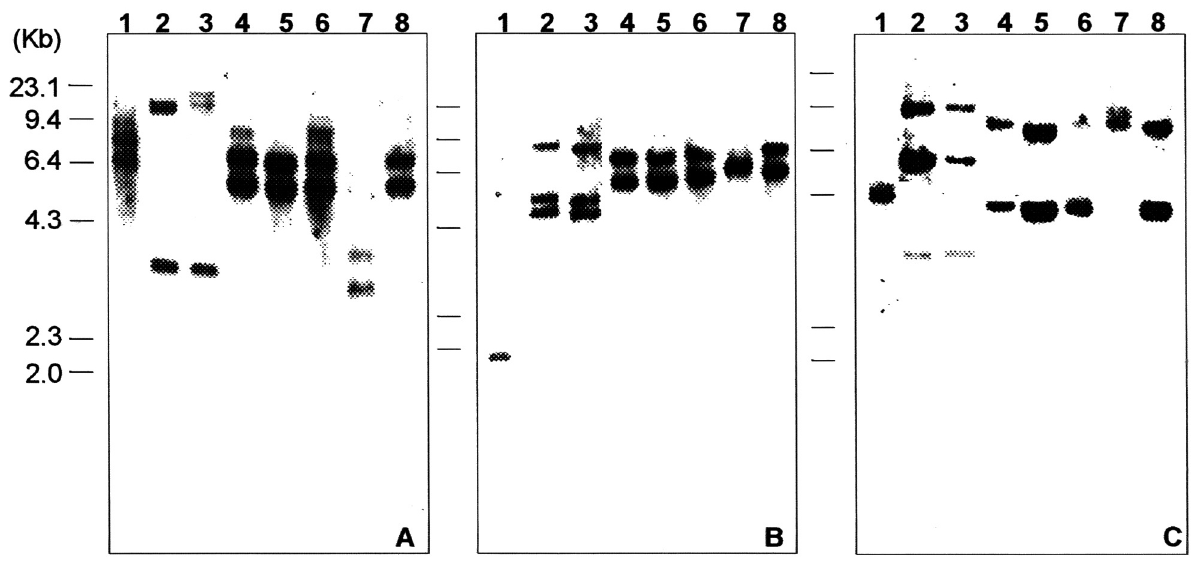
Figure2 -SouthernblotanalysisoftotalDNAfromdifferent Penicillium species.Therestrictionenzymes Eco RI(A), Sac I(B),and Sal I(C)wereusedto digesttotalDNAfrom P.chrysogenum (1), P.charlesii (2), P.citrinum (3), P.expansum (4), P.griseoroseum (5), P.italicum (6), P.janthinellum (7),and P. purpurogenum (8). Membranes were hybridized at 60 °C with the 420-bp fragment corresponding to a conserved domain of endoPG genes from P. griseoroseum . Phage λ DNA digested with Hin dIII